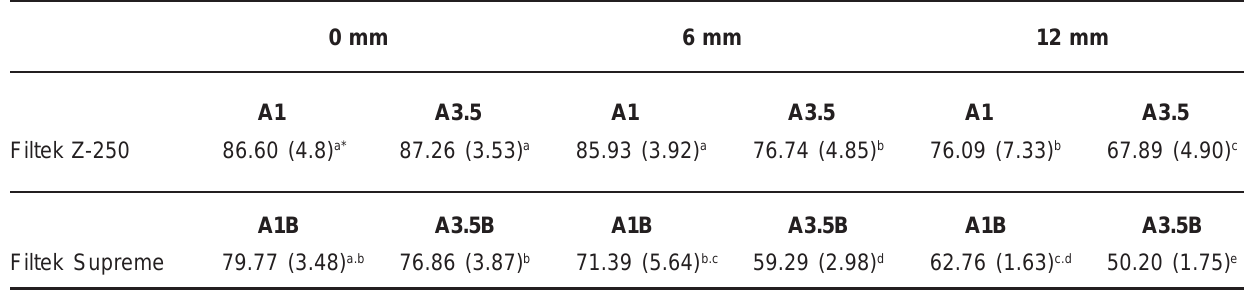
*Data are presented as mean (standard deviation), n=7. Groups with the same superscript letters are not significantly different (Tukey’s post-hoc multiple comparison test; p>0.05).